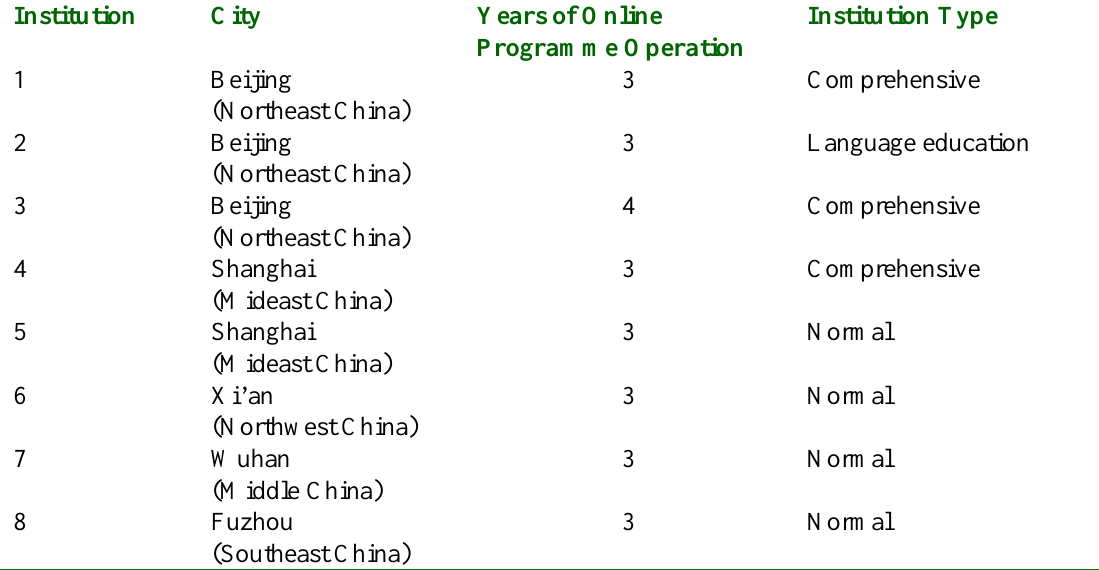
Table 1. Information on subject institutions